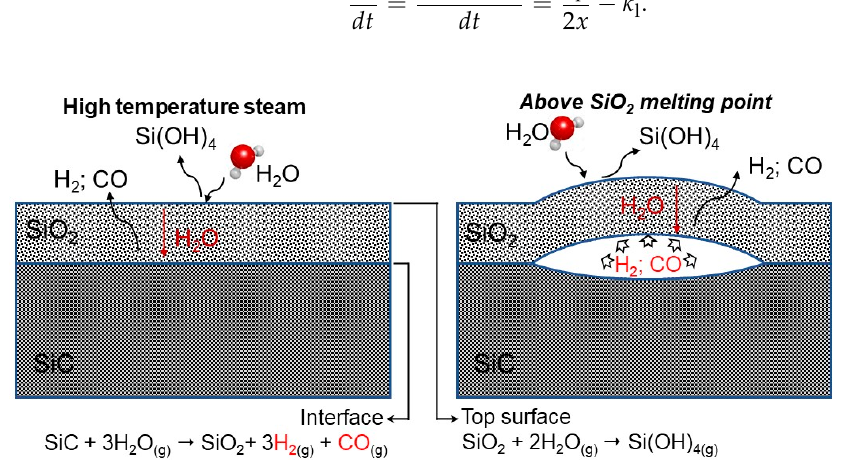
Figure 3. Illustration of SiC oxidation in steam at high temperatures.